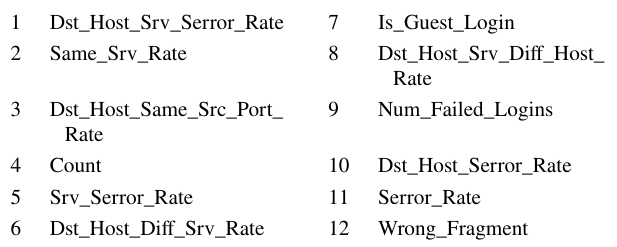
Table 7 Features selected after correlation-based feature selection Table 8 Features selected after sequential feature selection